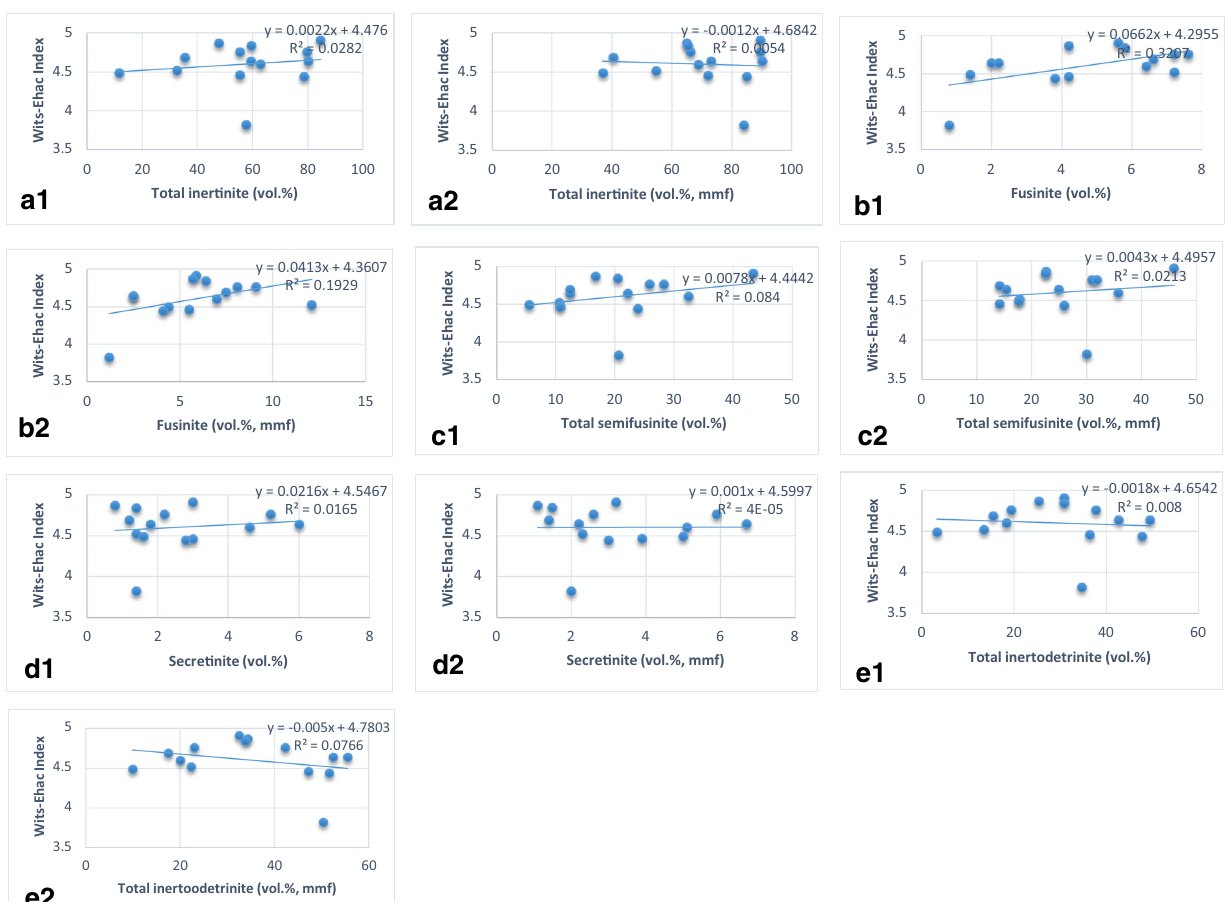
Fig. 9 Influence of inertinite and its group on spontaneous combustion of